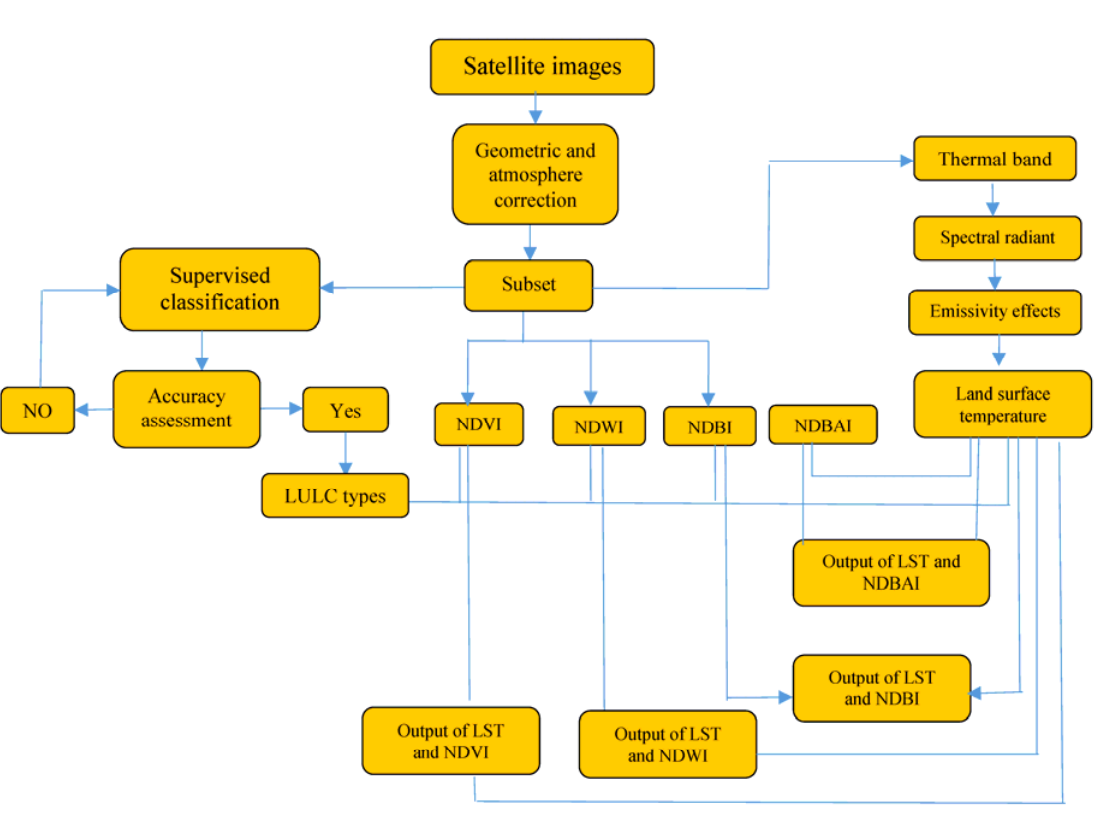
Figure 2. Flowchart showing the methodology.